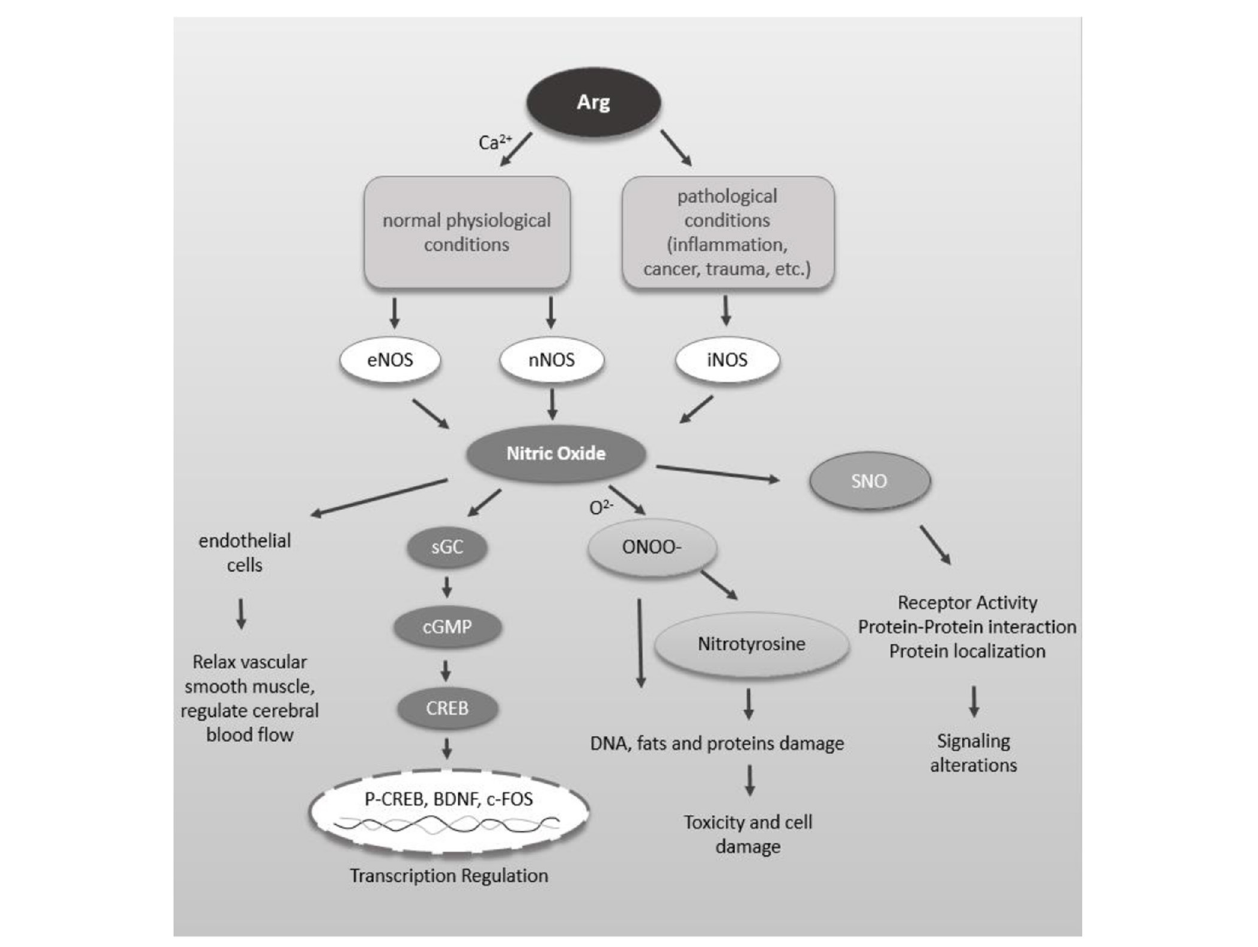
FIGURE 1 | Schematic diagram of NO function in the brain. NO can relax vascular smooth muscle, thereby regulating cerebral blood flow. Arg is catalyzed by different NOS to generate NO under physiological and pathological conditions. NO activates soluble guanylate cyclase to produce cGMP which interacts with many intracellular proteins such as PKG. PKG leads to CREB phosphorylation which leads into transcriptional activation of different genes. NO, directly and indirectly, leads to S-nitrosylation (SNO) of many proteins and receptors. SNO of proteins can alter the receptor activity, protein-protein interaction and protein localization leading to alteration in signaling. Increased level of NO increases proxynitrite formation, tyrosine nitration of proteins, which ultimately may lead into cell